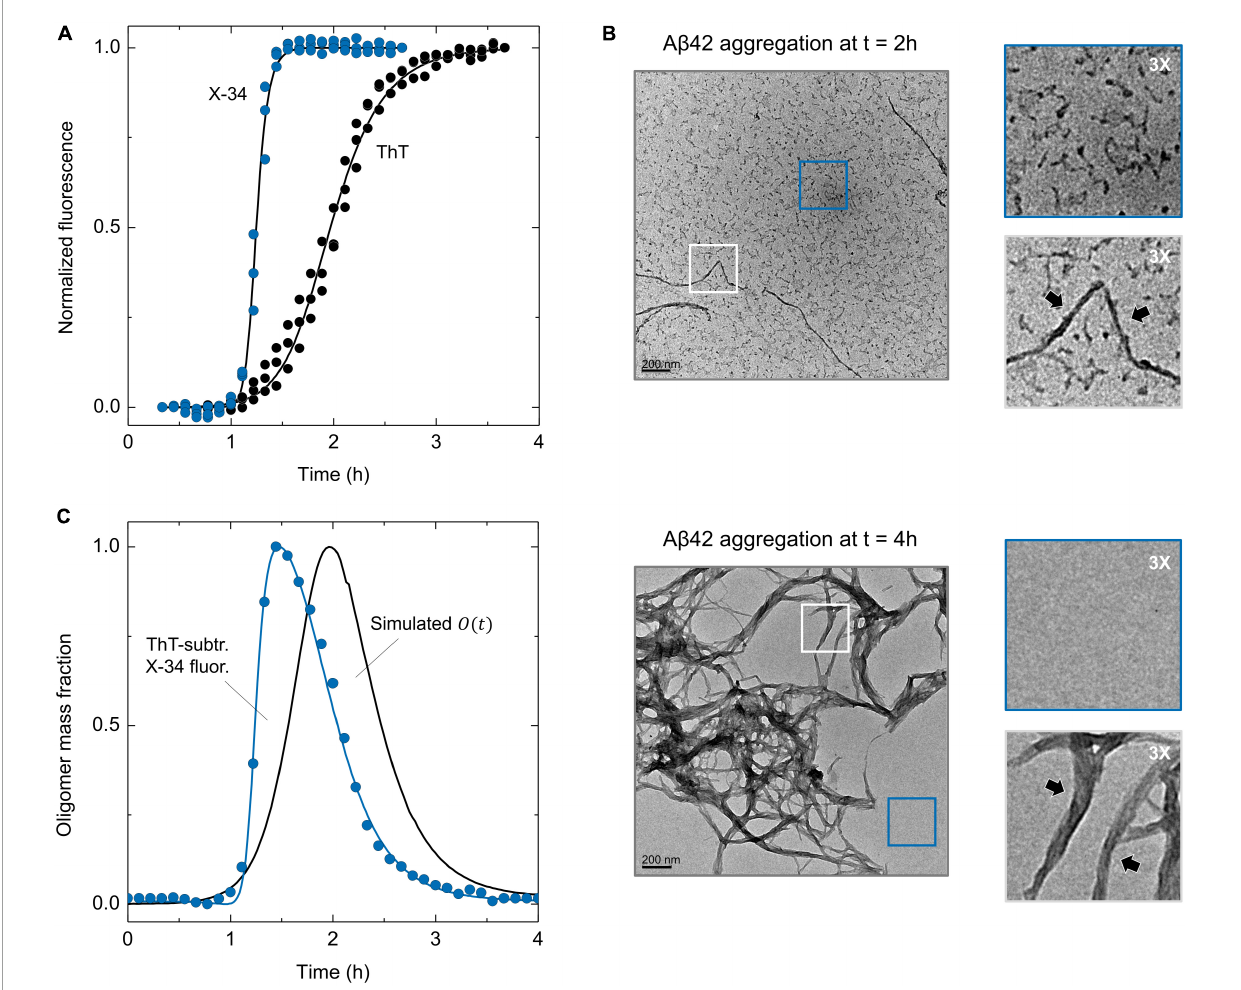
FIGURE3 ThT and X-34 differential fluorescence analysis of A β 42 aggregation and TEM imaging of X-34 positive oligomers. (A) Comparison of A β 42 (6 µ M) aggregation kinetics monitored by the ThT and X-34 fluorophores. (B) Representative transmission electron microscopy images of A β 42 aggregation at the time-points of (top) 2 and (bottom) 4 h. Gray and blue insets represent three-times ampliation of A β 42 amyloid-like fibrils and small oligomers/background, respectively. Black arrows pinpoint A β 42 amyloid fibrils. (C) Temporal evolution of ThT subtracted X-34 positive species (average values, n = 3) overlayed with A β 42 oligomer mass fraction progression [ O ( t ) ] calculated from aggregation rate constants (black solid line), portraying a significant intersection between experimental and simulated kinetics. See Supplementary Figures 3A–C for details on the mathematical formalism